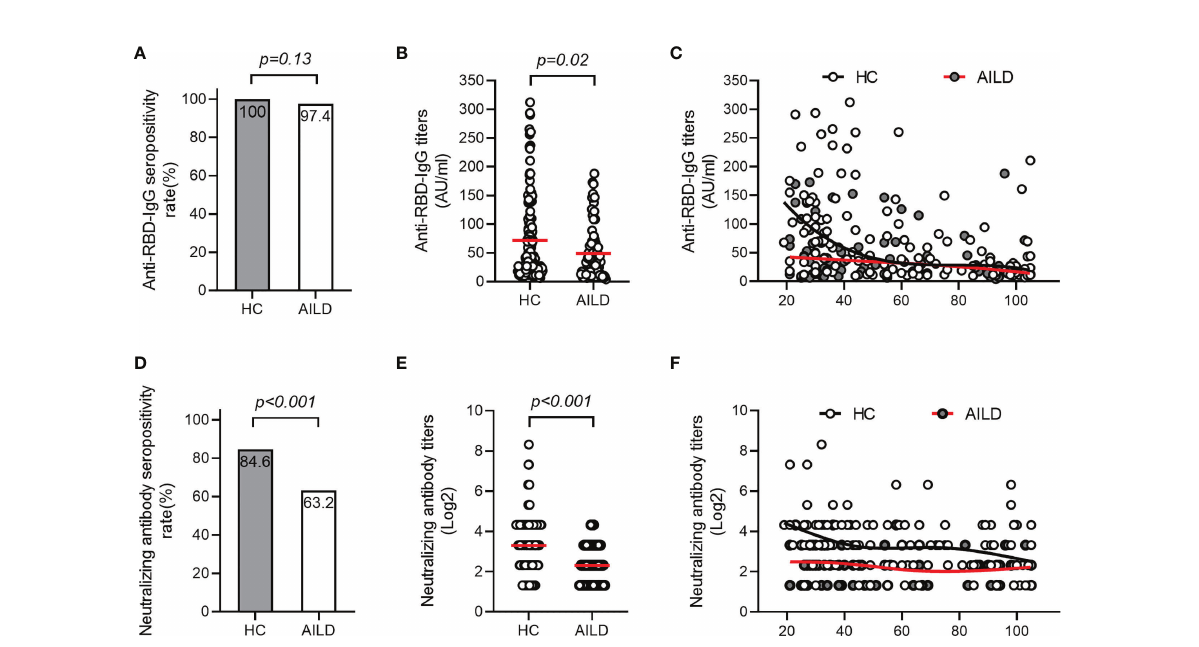
FIGURE 1 Antibody responses after COVID-19 vaccination in patients with AILD and healthy controls. The seropositivity rates and titers of anti-RBD-IgG (A, B) and NAbs (D, E) in patients with AILD and healthy controls. The distribution of anti-RBD-IgG (C) and NAbs (F) antibody titers over time in patients with AILD and healthy controls. AILD, autoimmune liver disease; anti-RBD-IgG, spike receptor-binding domain IgG antibody; NAbs, neutralizing